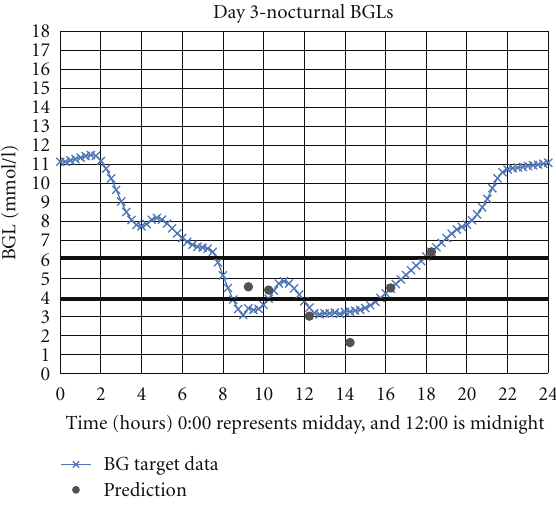
Figure 10: Predictions from trained ANNs on a test day which was not used during AIDA training. Each point represents a separate ANN, which was the best performing ANN over the 5 test days for a given prediction